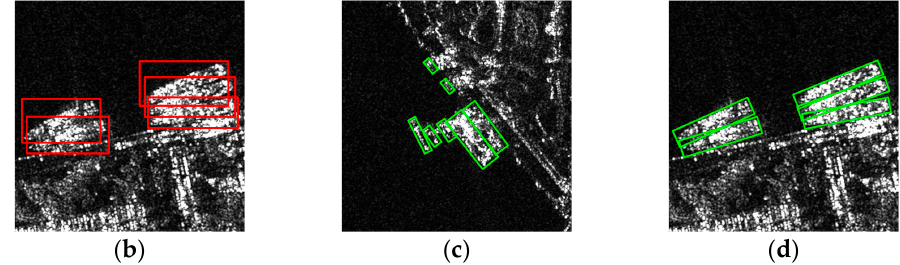
Figure 1. Densely arranged ships in complex inshore scenes. Here, ( a , b ) show the detecting of ship targets using the HBB-based RetinaNet [17]; ( c , d ) show the detecting of ship targets using the OBB-based RetinaNet with the proposed TDIoU loss and AW-FPN. The red and green boxes denote the detection results.